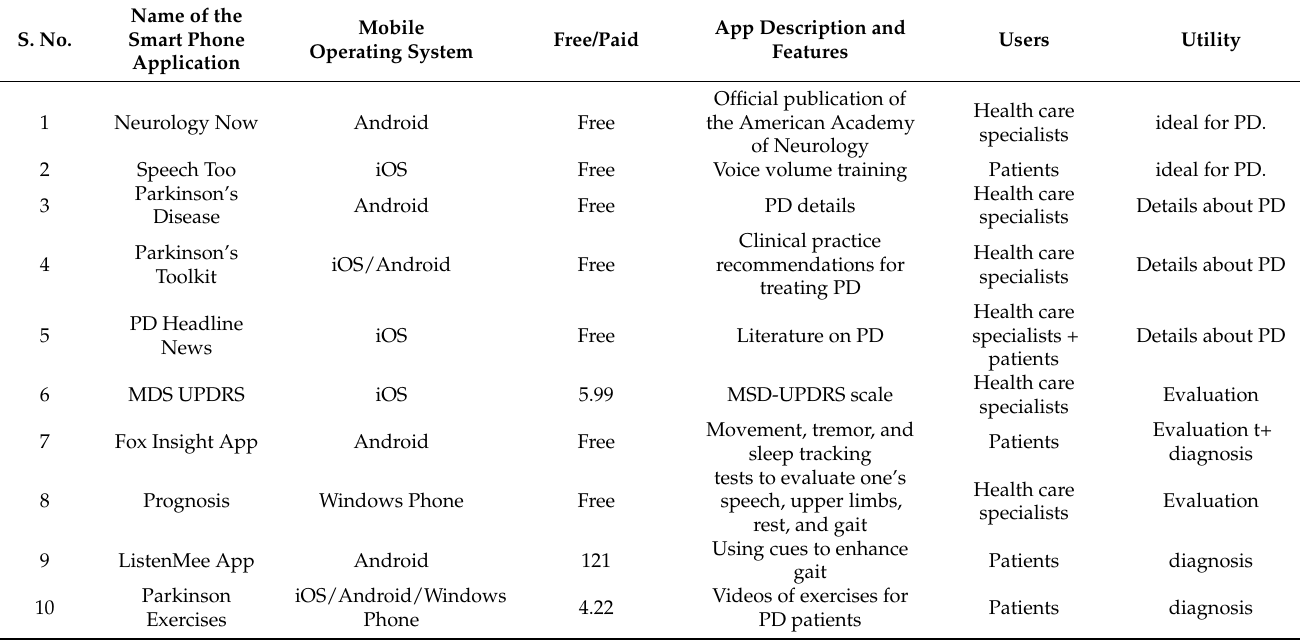
Table 8. Smart Phone Applications in Parkinson’s Disease